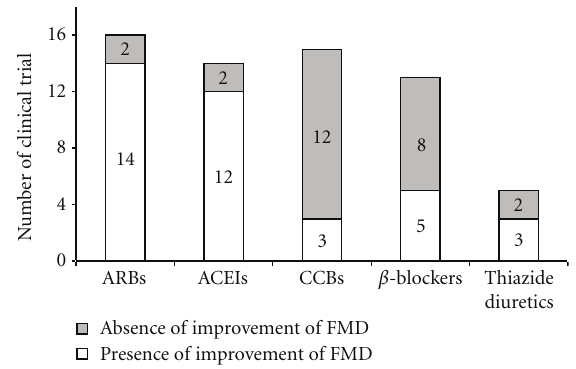
Figure 1: Columns indicate the number of clinical trials that showed the presence or the absence of significant improvement of flow-mediated vasodilation from baseline due to the intervention. FMD: flow-mediated vasodilation; ARBs: Angiotensin II receptor blockers; ACEIs: Angiotensin converting enzyme inhibitors; CCBs: Calcium channel